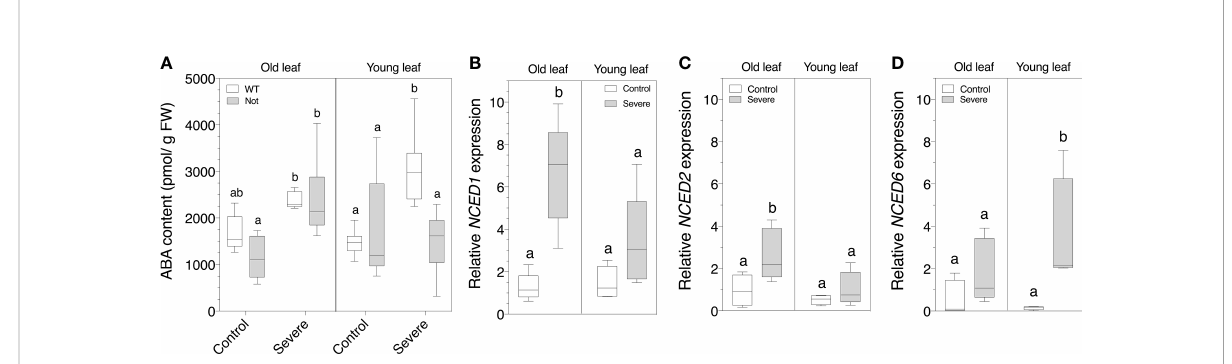
FIGURE 6 Quanti fi cation of leaf ABA content and NCED transcript levels of old (leaf no. 3) and young (leaf no. 8) leaves in wild-type (white) and notabilis (gray) after 7 days under control (EC of 2.5 dS/m) and severe (EC of 10 dS/m; [NaCl] = 94 mM) salt stress conditions. (A) Whole leaf ABA content (n = 5). (B-D) Relative expression in the wild-type plants of (B) NCED1 (n = 5), (C) NCED2 (n = 5) and (D) NCED6 (n = 5) under control (white) and severe (gray) salt stress conditions. Signi fi cant differences are indicated with different letters ( a = 0.05).